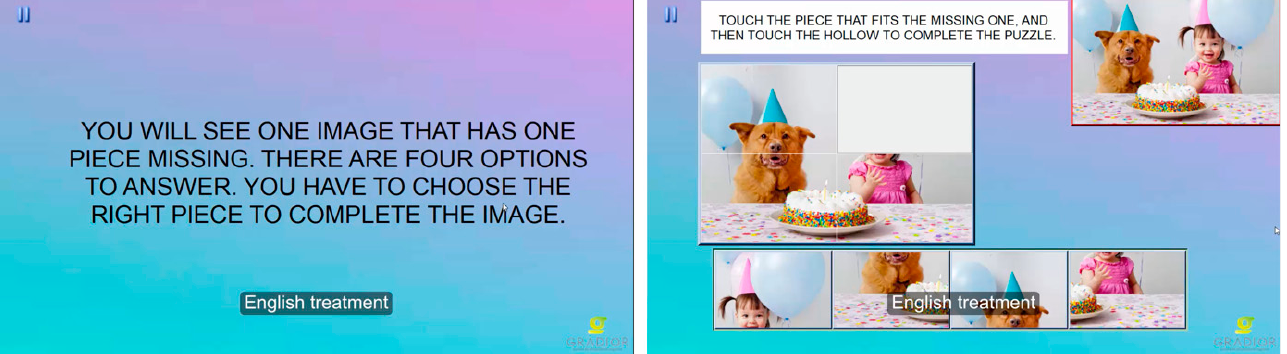
Figure 1. Puzzle exercise. Cognitive modality: executive function. II ; software pause.